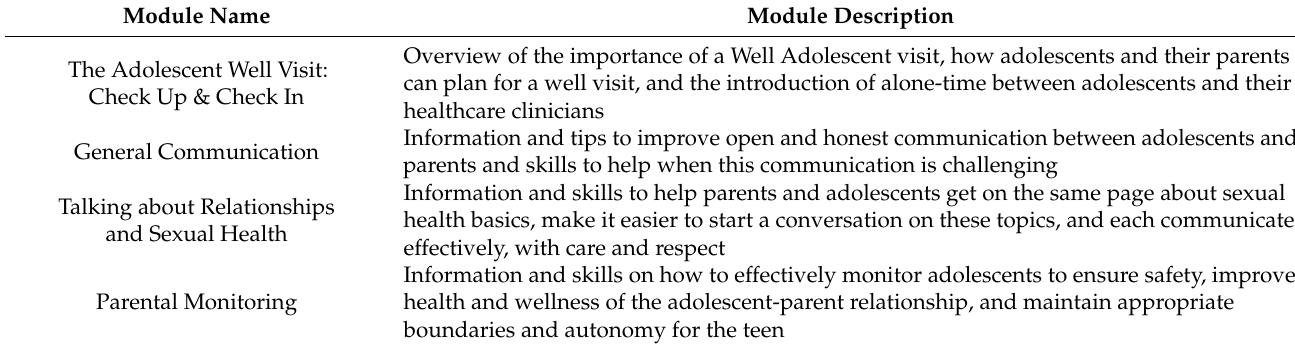
Table 1. TRUST modules and module descriptions.